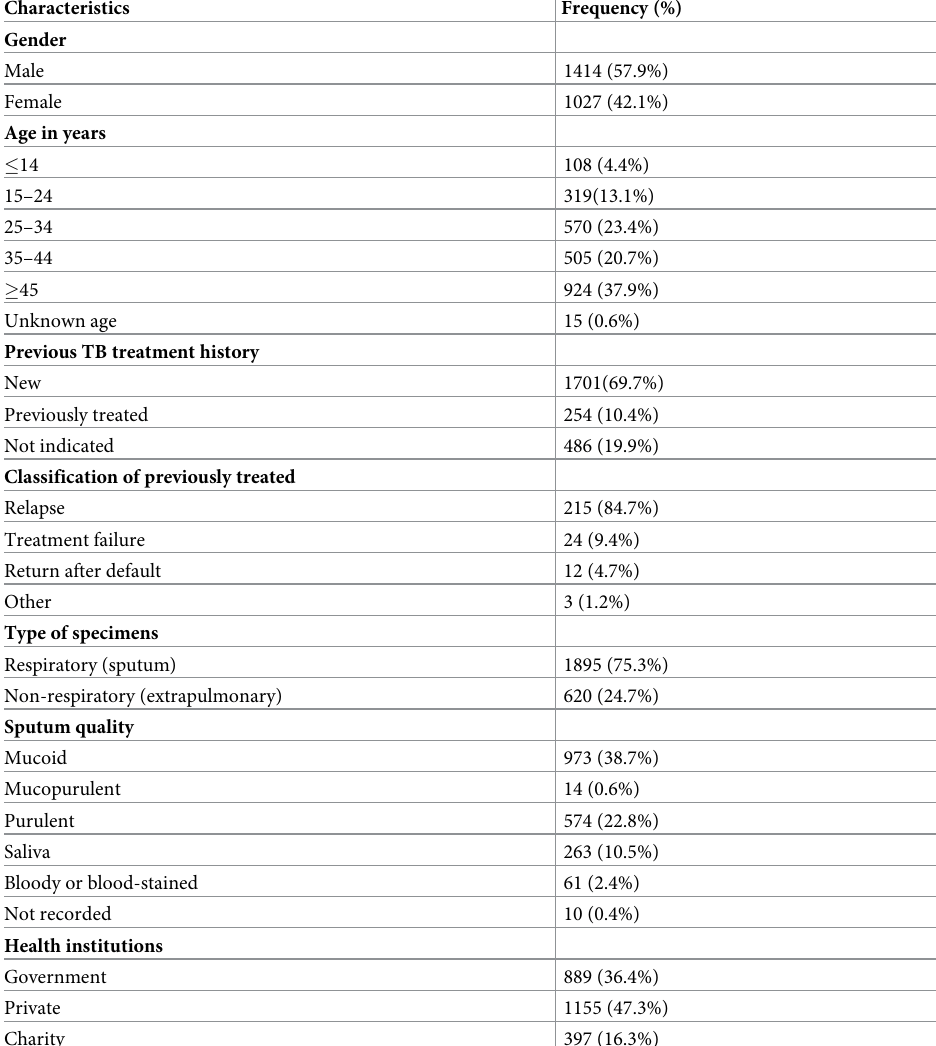
Table 2. Demographic and clinical characteristics of patients diagnosed with Xpert MTB/RIF molecular assay, 2018 (N = 2441).